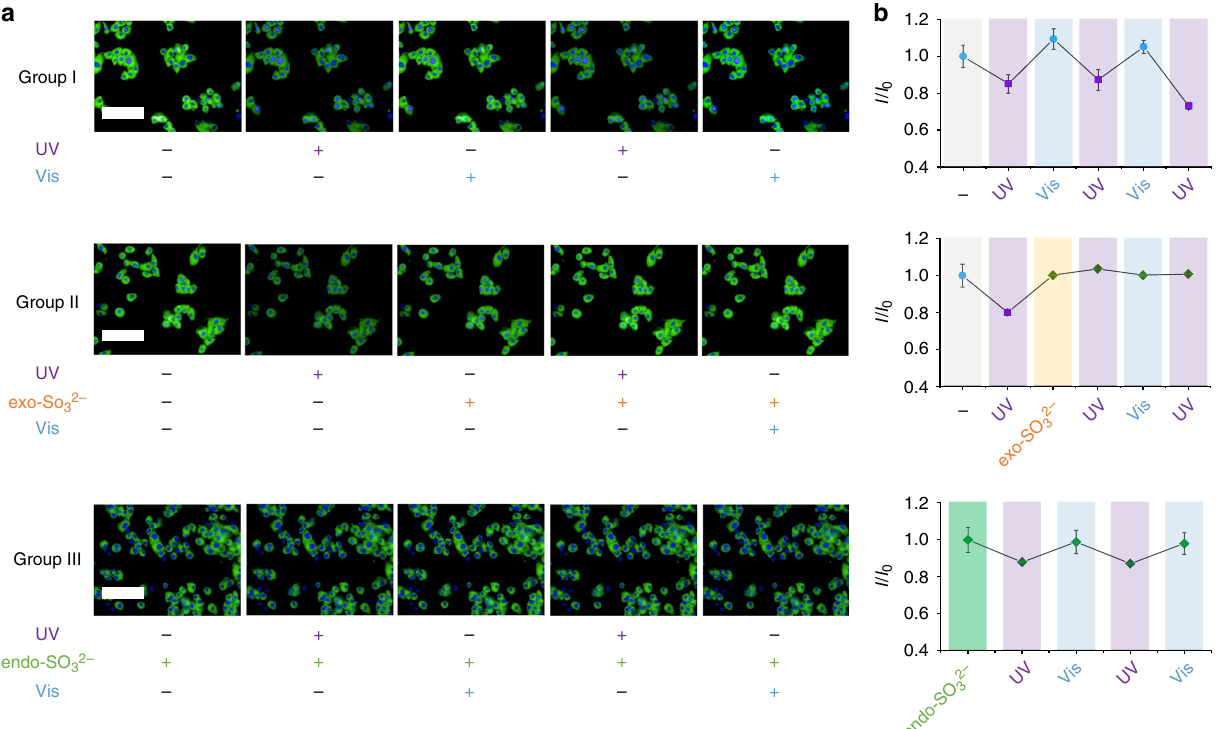
Fig. 6 Intracellular, remote light-controlled recognition of sul fi te by photochromic glycoprobes in Hep-G2 cells. a Fluorescence imaging of SP-Gal (20 μ M, Group I), SP-Gal (20 μ M) with exogenous (exo-) sul fi te (80 μ M, Group II) and SP-Gal (20 μ M) with endogenous (endo-) sul fi te (pretreating the cells with 400 ng mL − 1 lipopolysaccharide, Group III) upon alternate UV/Vis irradiations. b Fluorescence quanti fi cation of SP-Gal (Group I), SP-Gal with exogenous sul fi te (Group II) and SP-Gal with endogenous sul fi te (Group III) upon alternate UV/Vis irradiations, where I 0 and I are the initial fl uorescence intensity of SP-Gal and that of the corresponding SP-Gal/MR-Gal/MR-Gal-SO 3 2 − state upon photo-cycling and sul fi te reaction, respectively. For fl uorescence imaging, the excitation wavelength was 360 – 400nm and 440 nm and emission channel 410 – 480 and 450 – 550 nm for Hoechst and SP-Gal/SP-PEG, respectively (scale bar: 100 μ m, which is applicable to all images; The error bar represents s.d. ( n =